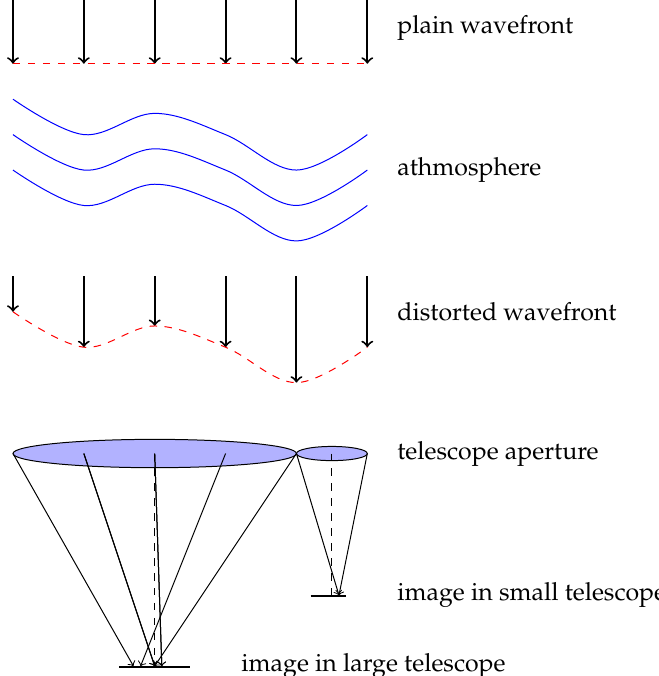
Figure 2. Resolution drop in an image of a point source due to atmospheric turbulence.